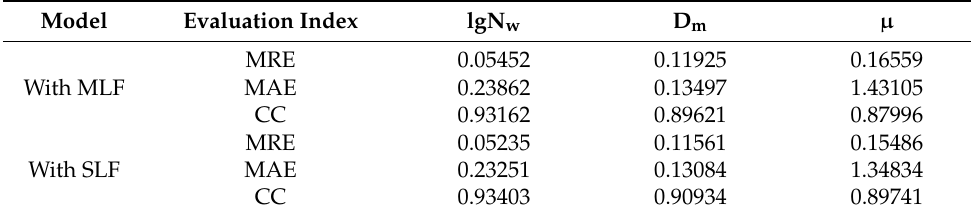
Figure 6. The 12-min scatter plot of lgN w , Dm, and µ fitted by the observed data and predicted by the model, in which ( a – c ) are modeled with MLF and ( d – f ) with SLF. The red line denotes a linear trend line of the scattered points, and the color mark represents the Gaussian kernel density estimation. Table 3. The 12-min prediction evaluation results of the test